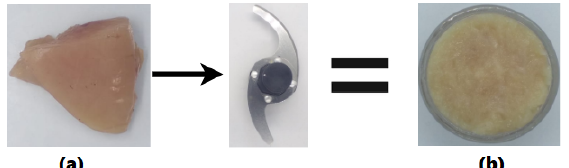
Figure 1. The entire process of sample preparation; ( a ) represents chuck meat; and ( b ) represents the minced